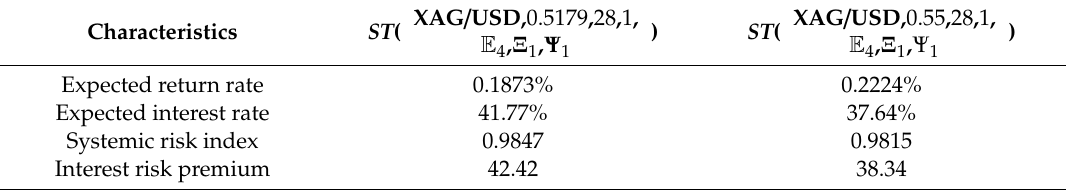
Table 8. Juxtaposition of global characteristics of ST systems applied for the XAG/USD market. Characteristics